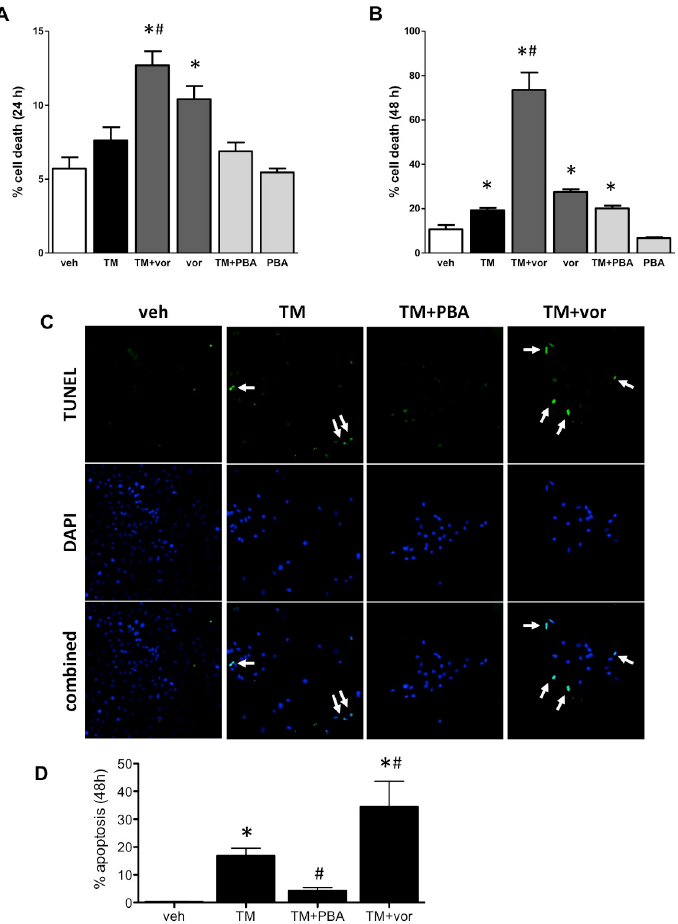
Fig 2. (A) Human proximal tubular (HK-2) cells were treated with tunicamycin (TM), TM with 4-phenylbutyrate (TM+PBA), TM with vorinostat (TM+vor), 4-phenylbutyrate alone (PBA), or vorinostat alone (vor) for 24 hrs. TM +vor and vor increased cell death. (B) After 48 hrs, TM increased cell death, which was not inhibited by PBA. Vorinostat increased cell death, and exacerbated TM-mediated cell death. (C) Cells were also stained for apoptotic cell death (green; arrows) after 48 hrs. TM induced apoptosis, which was inhibited by PBA. Vorinostat exacerbated TM- induced apoptotic cell death. � , p < 0.05 vs veh; #, p < 0.05 vs